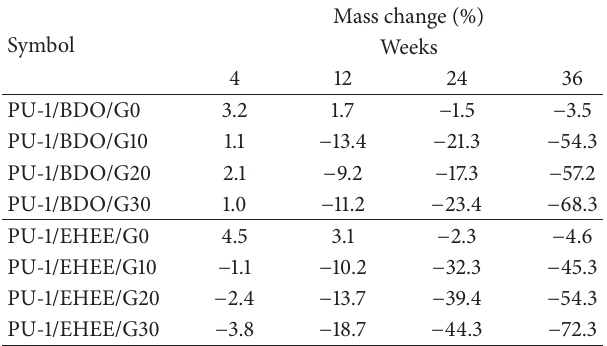
Table 6: Mass loss data for PU foams after hydrolytic degradation.